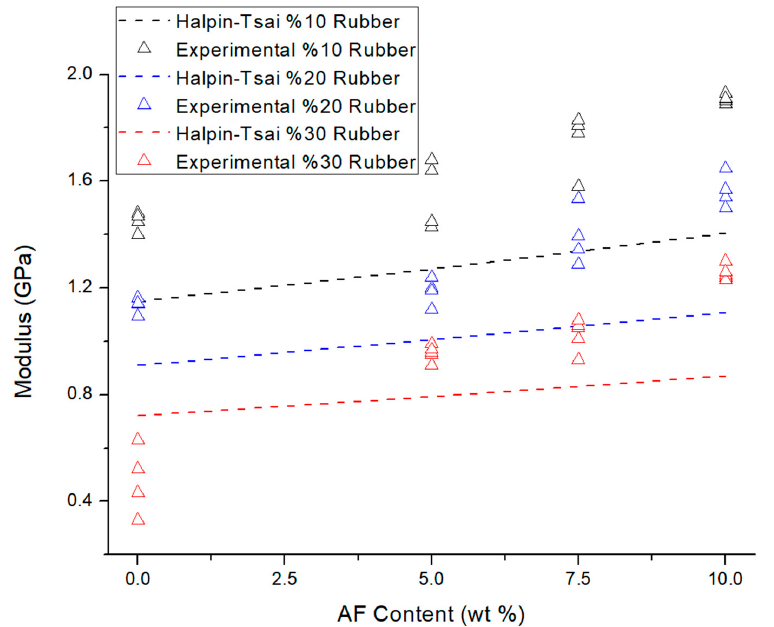
Figure 4. Experimental results and Halpin–Tsai model comparison on elasticity modulus of LRAL composites by the increasing content of AF.